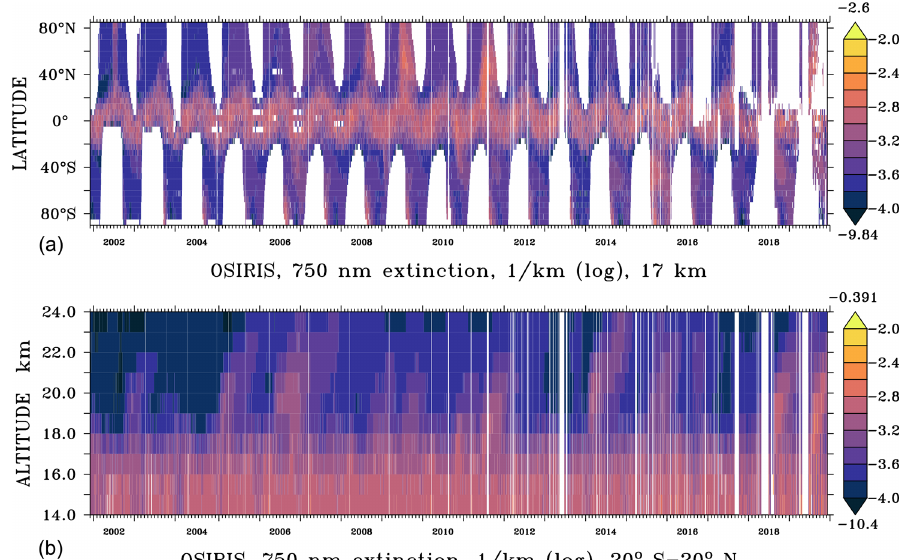
Figure 4. The logarithm log(km − 1 ) of the aerosol extinction as derived from the OSIRIS instrument at a 750nm wavelength by Bourassa et al. (2012a) and Rieger et al. (2019). The dataset spans the period 1 December 2001–December 2019 (5d averages). Horizontal distribution at 16.5km altitude (a) and vertical distribution for tropical regions 20 ◦ S–20 ◦ N (b) . Maximum and minimum values appear above (yellow) and below (dark blue) the colour keys, respectively. White: no